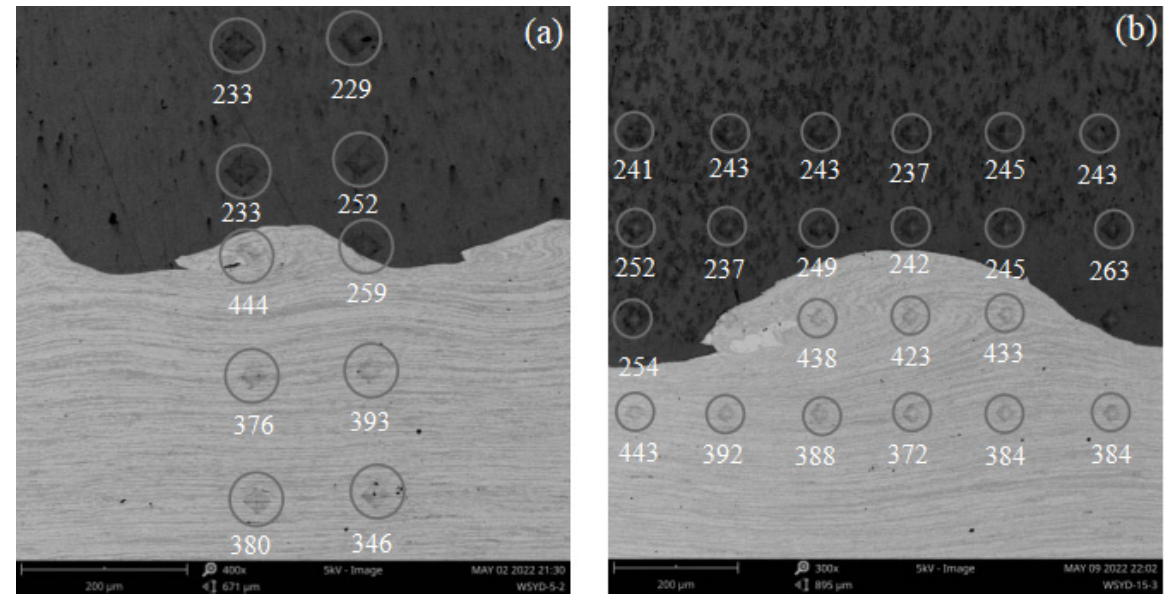
Figure 9. Vickers hardness test results: ( a ) stand-off = 5 mm; ( b ) stand-off = 15 mm.